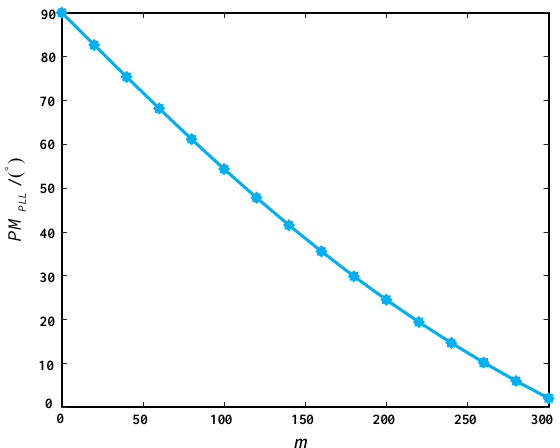
Figure 10. Relationship curve between phase margin of CCF-MFOF-PLL and m .